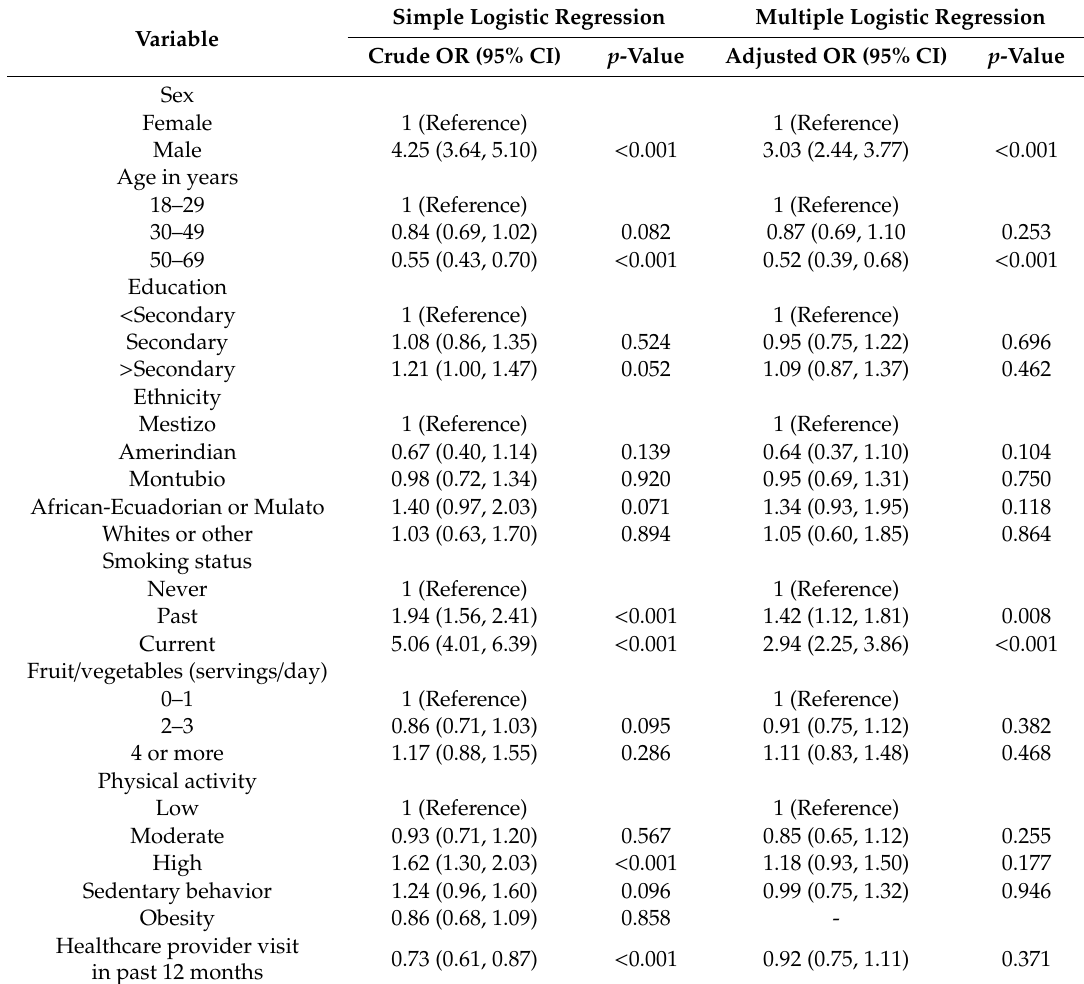
Table 3. Associations with heavy episodic alcohol consumption.